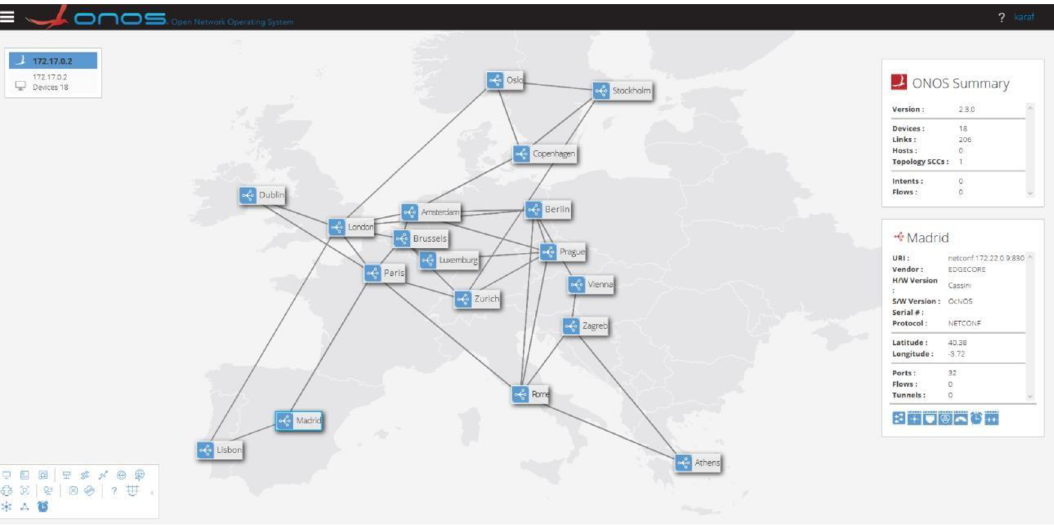
Figure 7. Emulated optical topology deployed on ONOS.